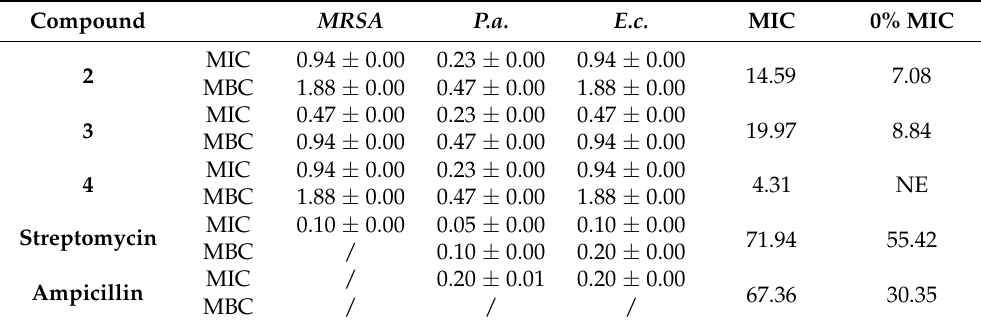
Table 2. Antibacterial activity and nhibition of biofil formation against resistant strains (MIC/MBC in